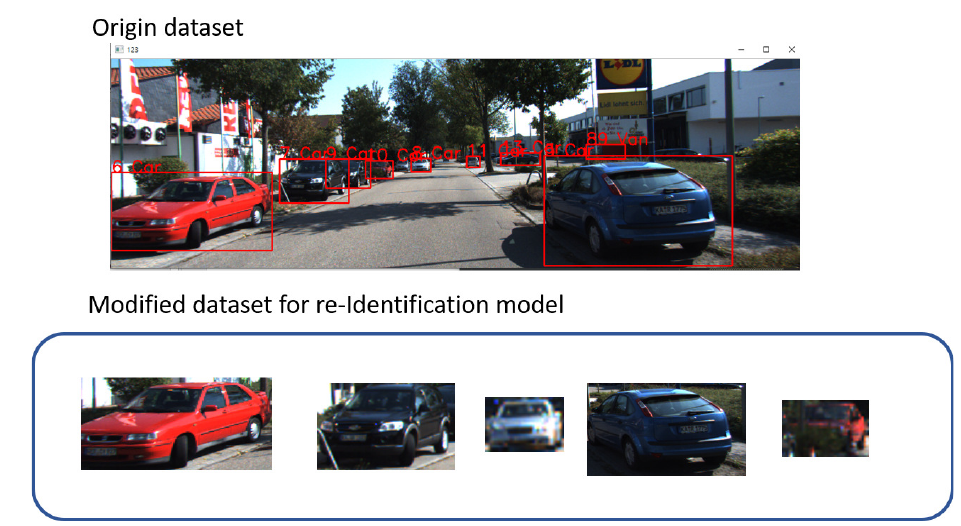
Figure 10. Generated ID dataset for KITTI multi-object tracking